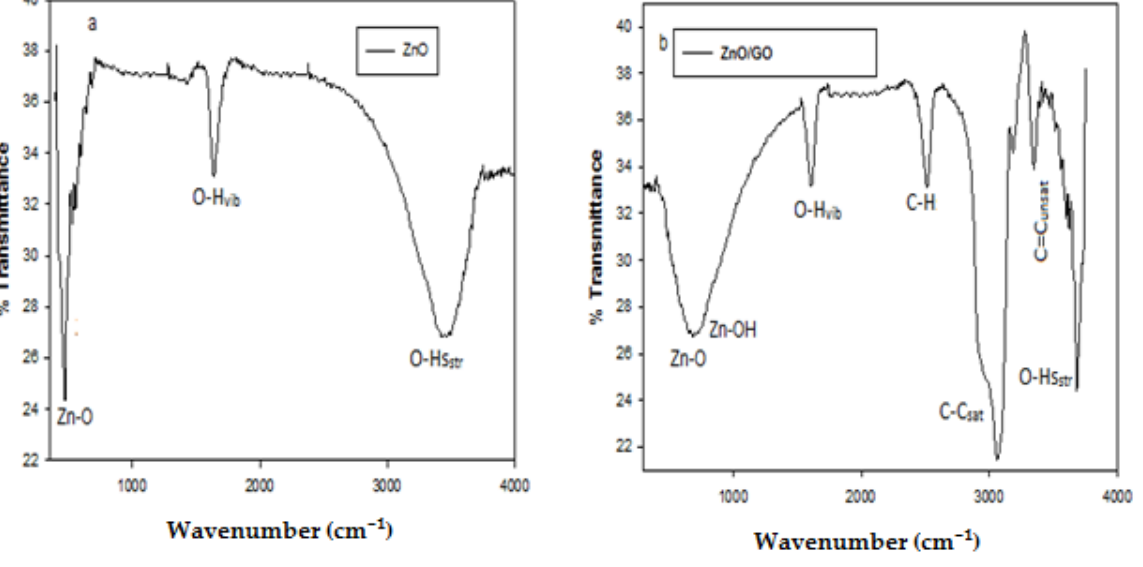
Figure 5. FTIR spectra of ZnO ( a ) and ZnO/GO ( b ).